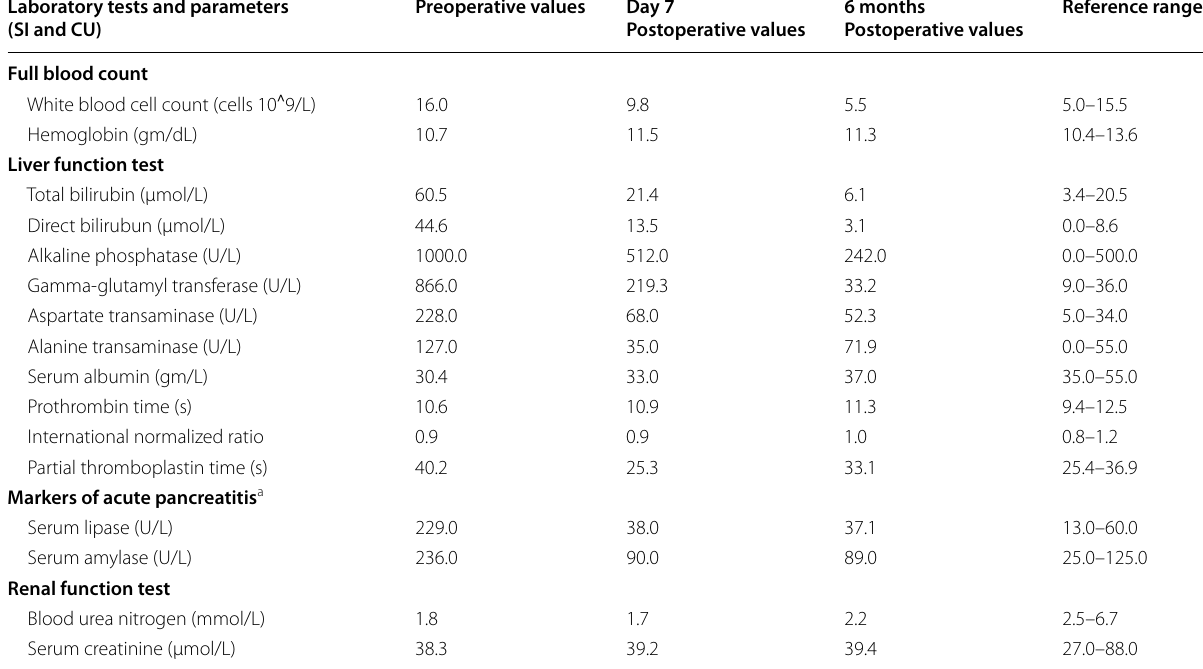
μmol / L , micromole/liter; CU , conventional units; gm / dL , gram/deciliter; gm / L , gram/liter; L , liter; mmol / L , millimoles/liter; s , seconds; SI , International System of Units; U / L , units/liter. a Nonspecific